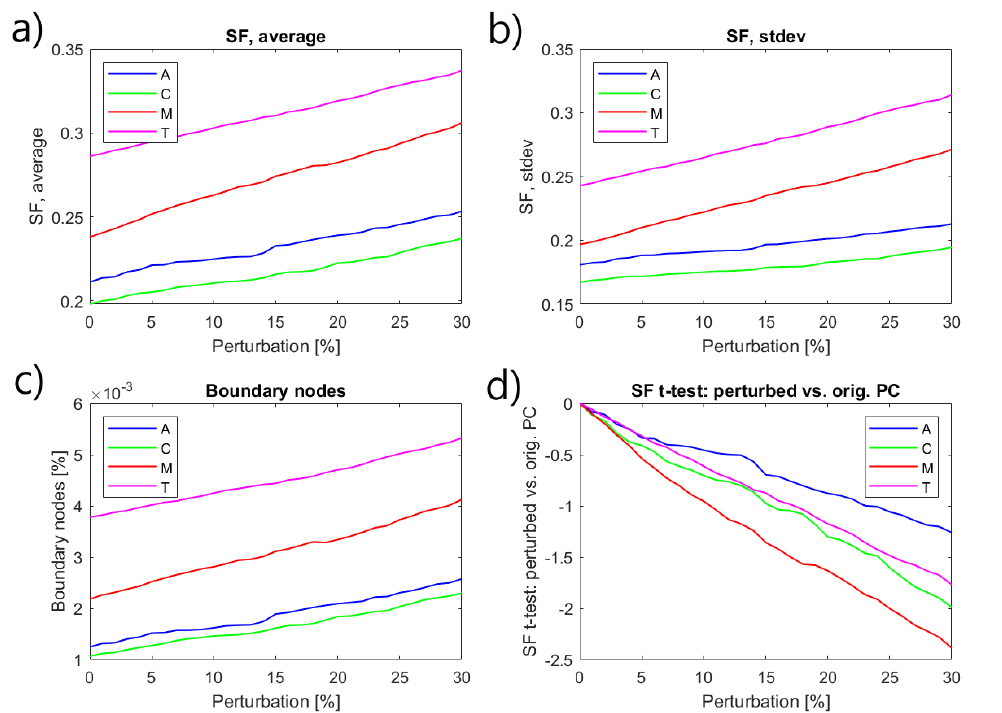
Figure 13. Exemplary comparison of point cloud smoothness of different plants (A—arabidopsis, C—cucumber, M—maize, T—tomato) in dependency on random model perturbation. ( a ) Average smoothness factor (SF) of different plants, ( b ) stdev of SF distribution in different plants, ( c ) fraction of boundary points in % detected by thresholding of SF values larger than > 0.5, and ( d ) t -test values computed from comparison of SF distributions of randomly perturbed plant point clouds vs.